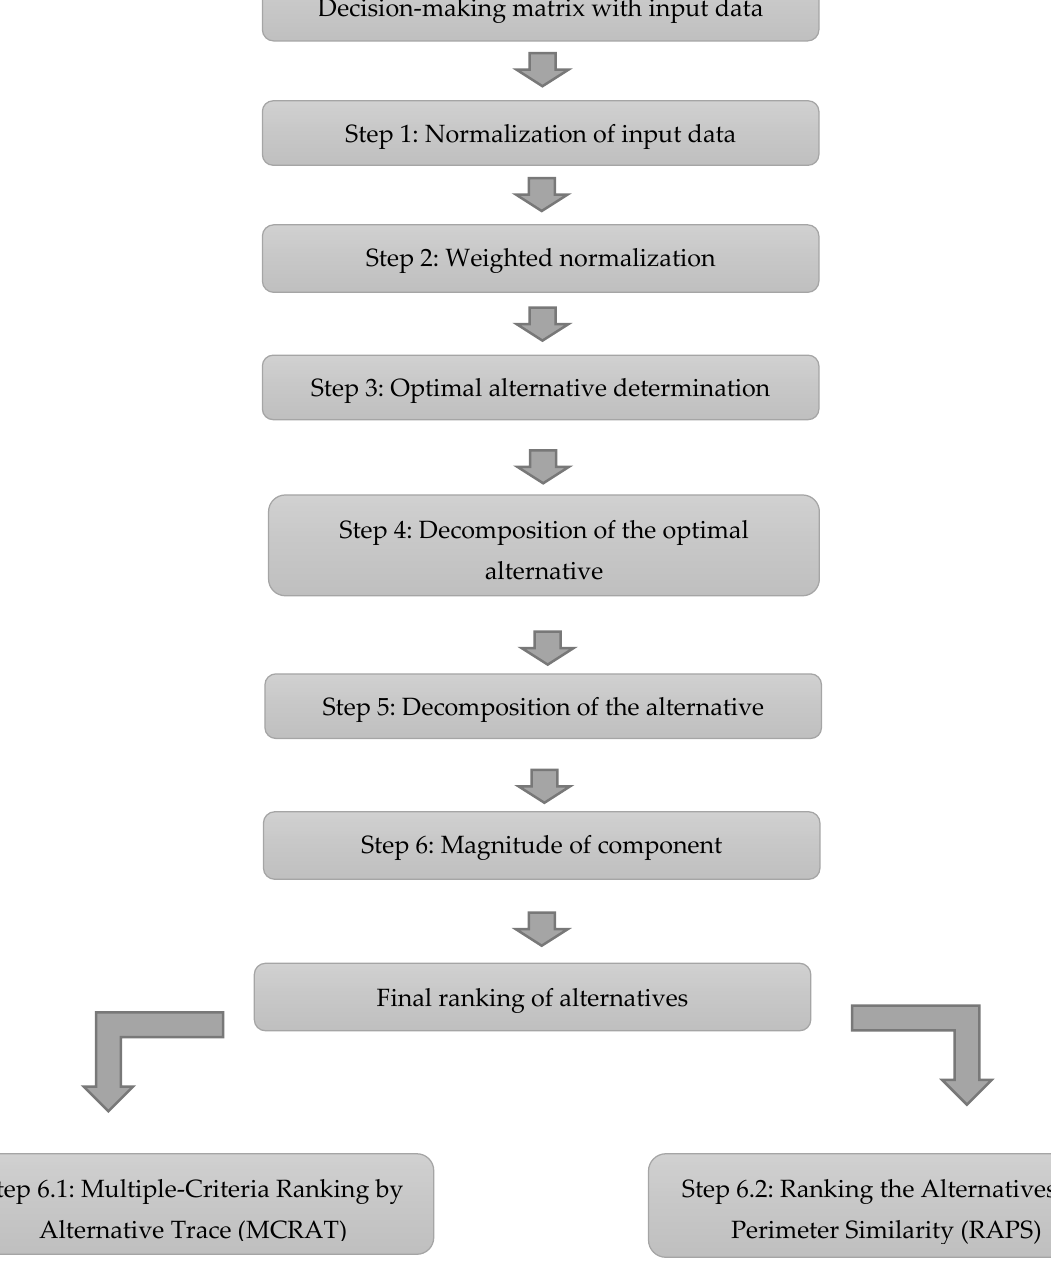
Figure 1. MCRAT and RAPS flow chart.